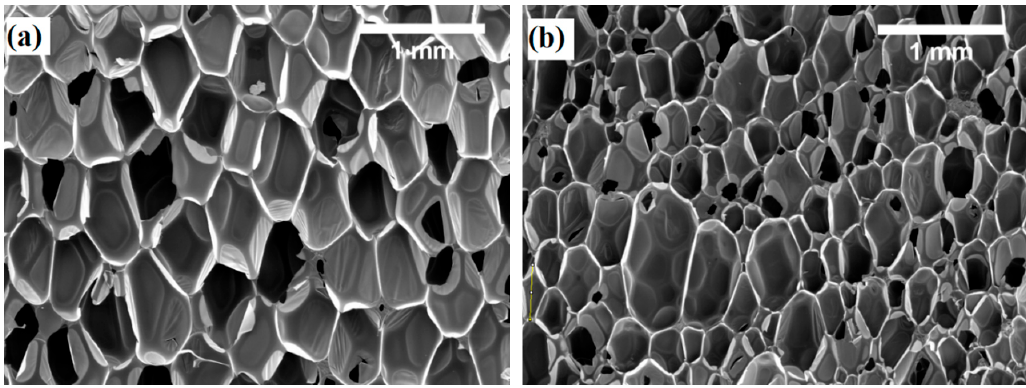
Figure 5. Microstructure of rigid polyurethane foam (magnification ×50) at an apparent density of ( a ) 30 kg/m 3 and ( b ) 40 kg/m 3 .